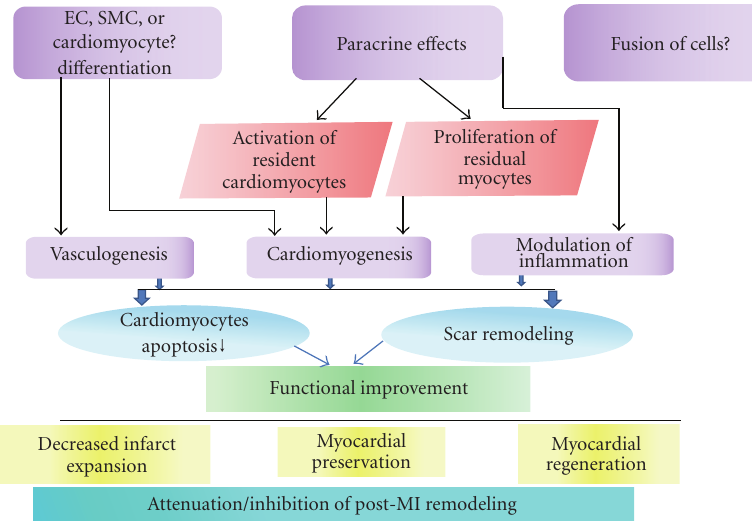
Figure 1: Mechanism of action of stem cells for cardiac functional